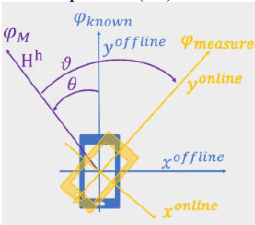
Figure 8. The illustration of magnetic heading